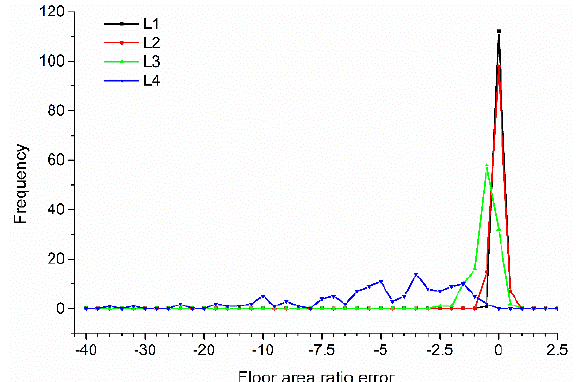
Figure 9. Block FAR error distribution comparison among four block FAR